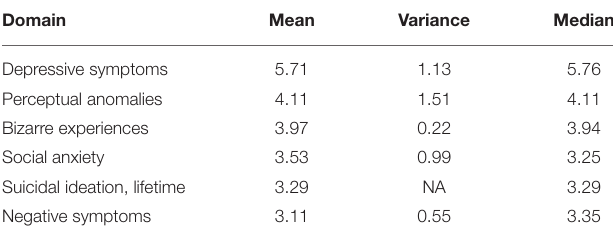
TABLE 8 | Mean strength of the 6